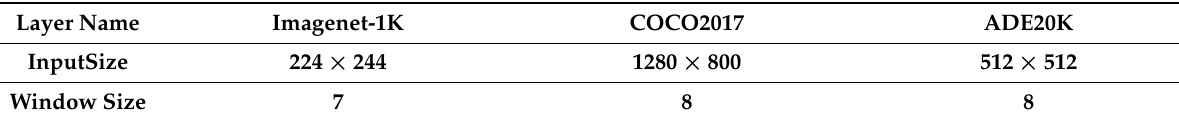
Table 1. The three configurations for different visual tasks, i.e., image classification, object detec- tion, and semantic segmentation, on three corresponding benchmark datasets, i.e., Imagenet-1K, COCO2017, and ADE20K,